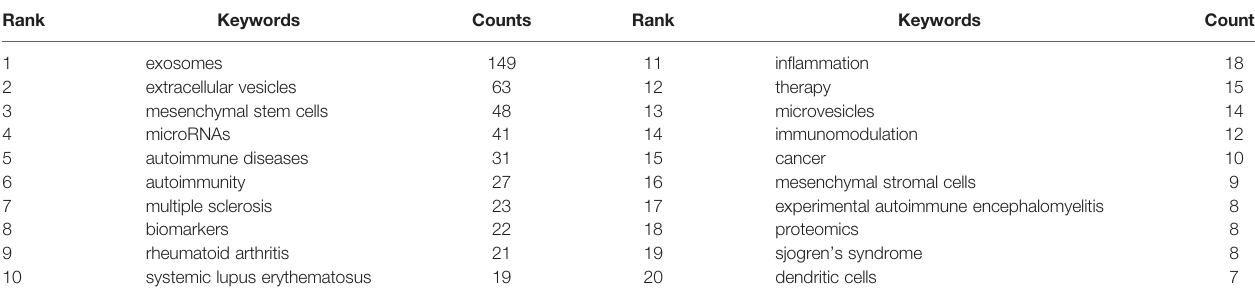
TABLE 6 | Top 20 keywords on research of exosomes in